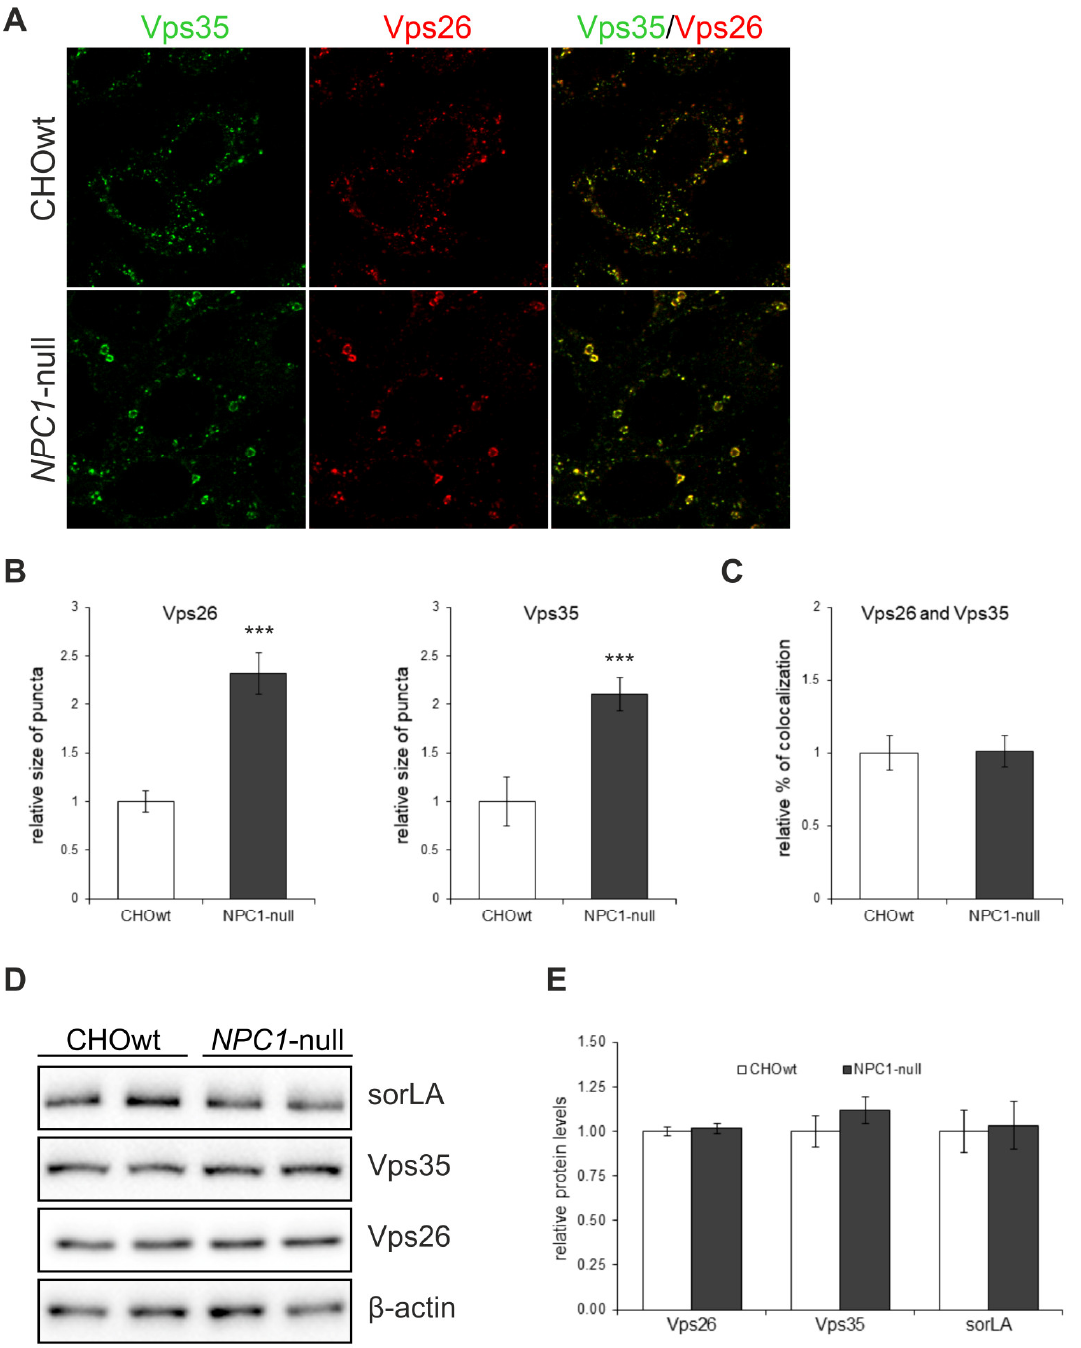
Figure 1. Retromer proteins accumulate in enlarged vesicles at the periphery in NPC1 -null cells compared to CHOwt. ( A ) The cells were grown in 10% FBS in DMEM/F12 media, fixed and stained for Vps26 (green) and Vps35 (red). Cells were analyzed by confocal microscopy, and fluorescent signals were quantified using ImageJ software. ( B ) Size of Vps26 or Vps35-positive puncta and ( C ) colocalization of Vps26 and Vps35 were compared between CHOwt and NPC1 -null cells, *** p < 0.001, n = 30 cells per group from three different experiments. ( D , E ) The levels of retromer proteins Vps26 and Vps35 and retromer receptor sorLA, analyzed by western blot, did not reveal any differences in the protein levels. Protein signals were quantified using the ImageJ software. The statistical significance of the tests was set at p < 0.05. The data are shown as mean ± SD normalized to control and represent data from three different experiments in duplicates, n = 6 per group. Scale bar—20 µ